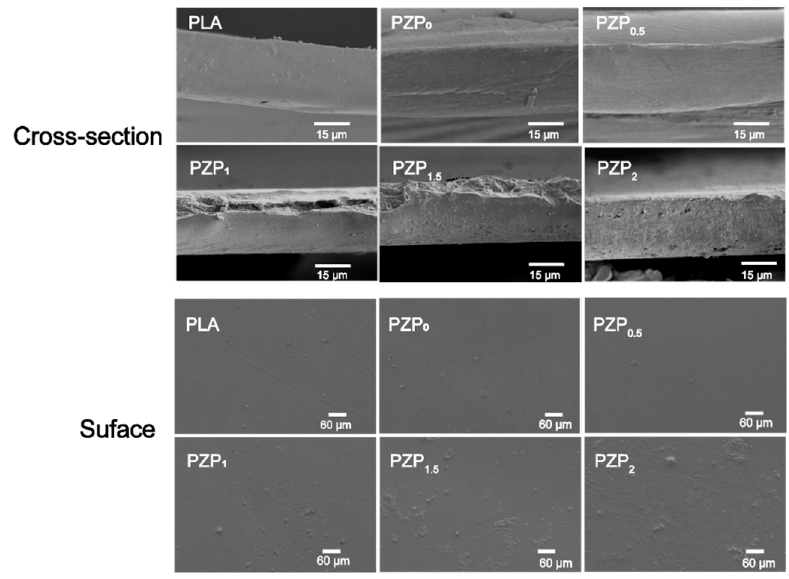
Figure 1. SEM images of PLA-based composite films.